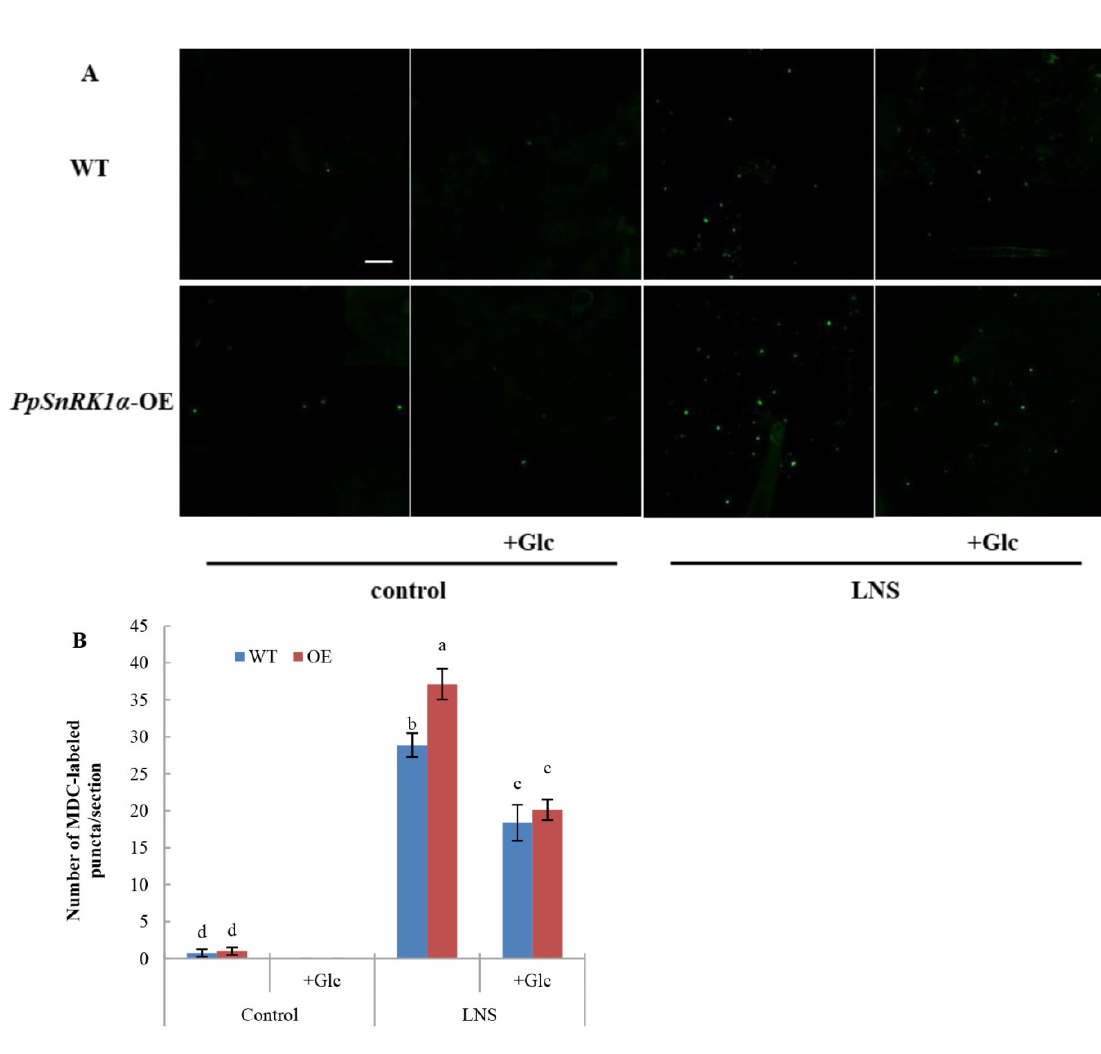
Figure 4. Activation of TOR by Glc inhibits autophagy. ( A ) Autophagosomes by MDC staining in leaves of WT and OE plants. Autophagosomes by MDC staining are shown as green signals. Bars: 50 µ m. ( B ) The number of autophagosomes by MDC staining per image in ( A ) was quantified to calculate the autophagic activity. Different lowercase letters indicate significant differences according to Duncan’s multiple range test ( p <